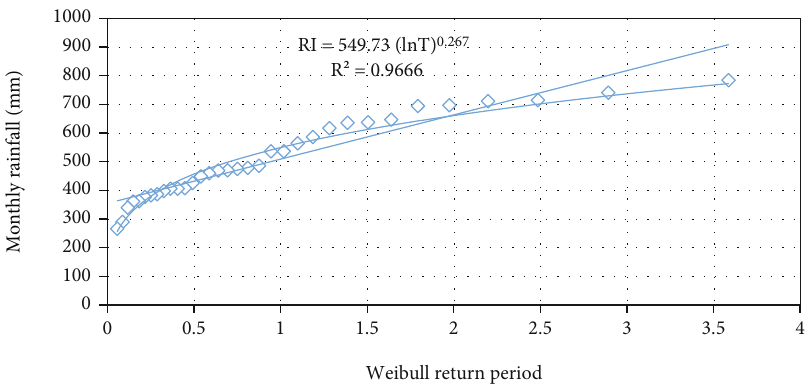
Figure 7: Weibull ’ s probability plotting position.